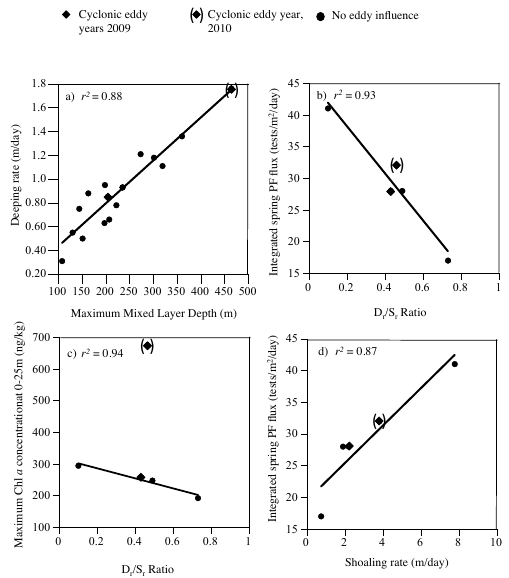
Figure 10. (a) Correlation between the maximum mixed layer depth and deepening rate of the mixed layer for years 1995–2011. (b) Cor- relation between the deepening:shoaling rate ( D r /S r ) ratio of the mixed layer depth for all years studies excluding 2000 and inte- grated PF flux during the spring blooms which ranged from De- cember to May, (c) maximum chlorophyll a concentrations in the surface ocean during the spring bloom for all years studied, ex- cluding the anomalous year 2010 in parentheses, (d) correlation between the shoaling rate and integrated flux of total PF over the spring bloom period which ranged from December to May. Dia- monds indicate years with eddy influence 2009 and diamond with parentheses = 2010. Round points are years without eddy influence.